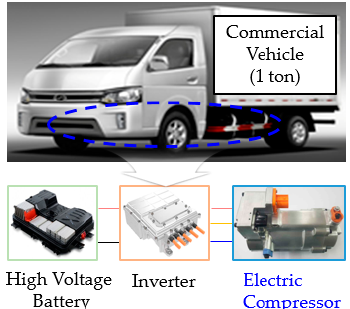
Figure 1. Cooling components of an electric vehicle.